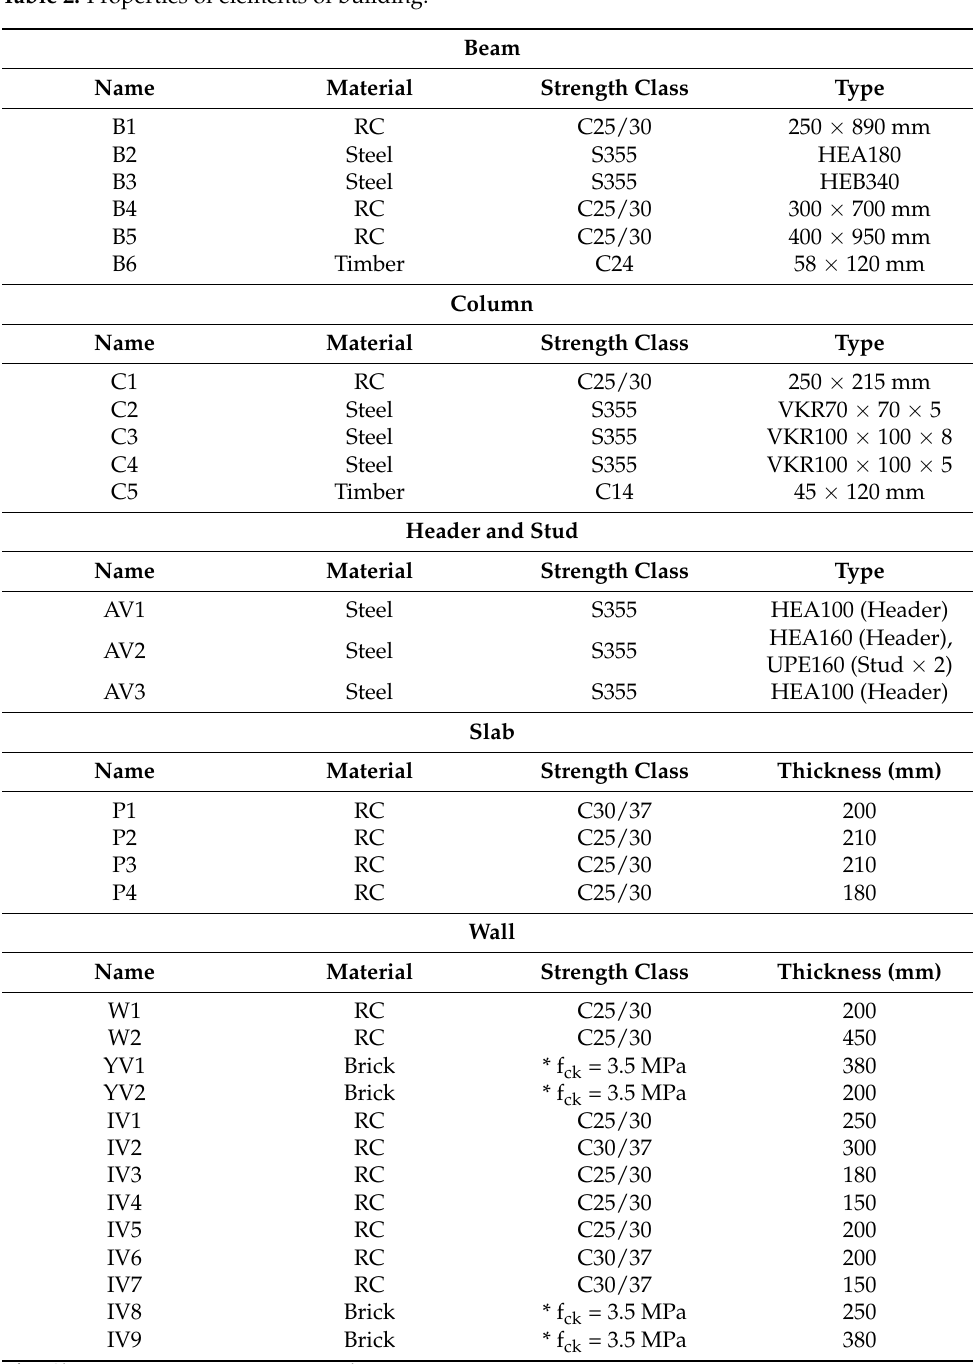
Table 2. Properties of elements of